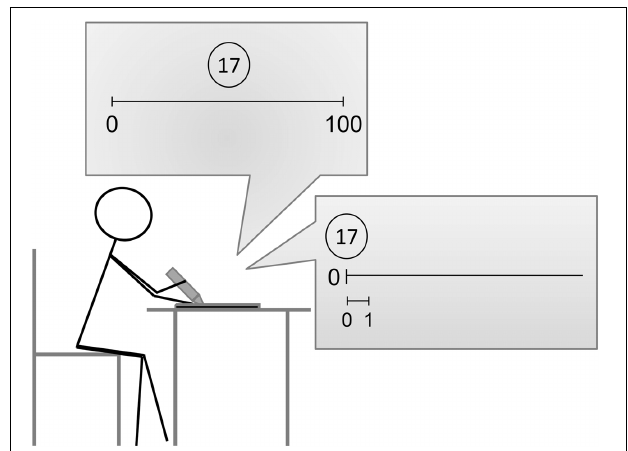
FIGURE 1 | Schematic illustration of the bounded number line task and the new unbounded version of the task.